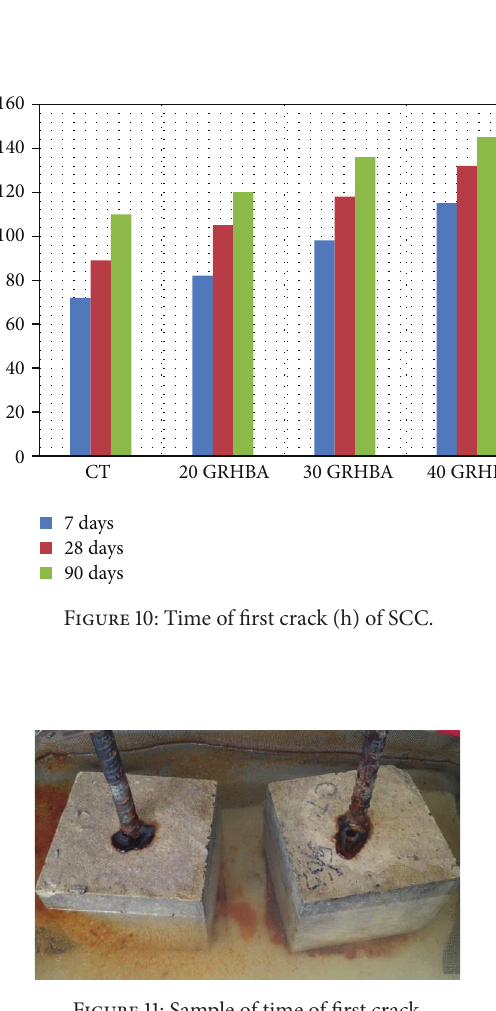
Figure 11: Sample of time of first